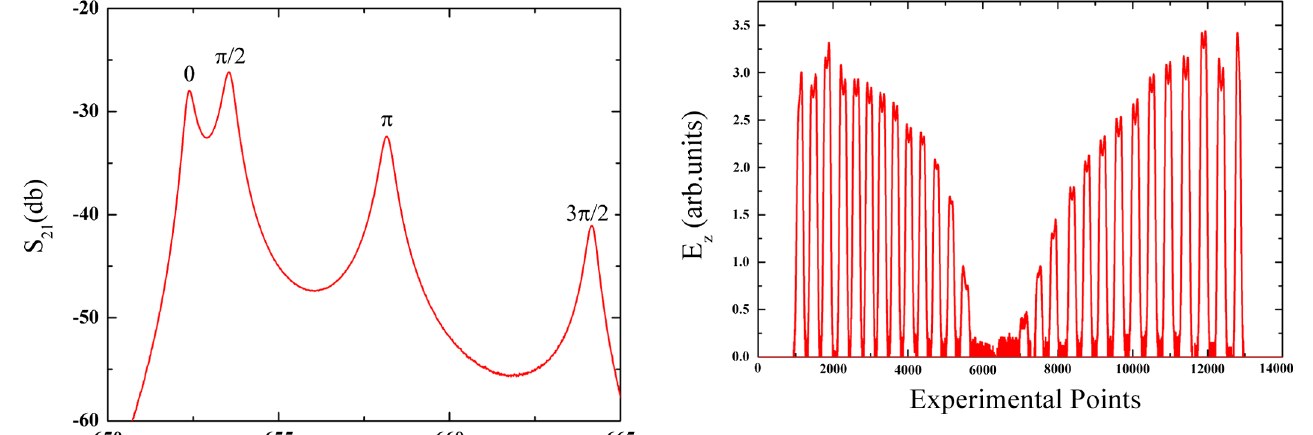
FIG. 43. The measured field distribution of the H